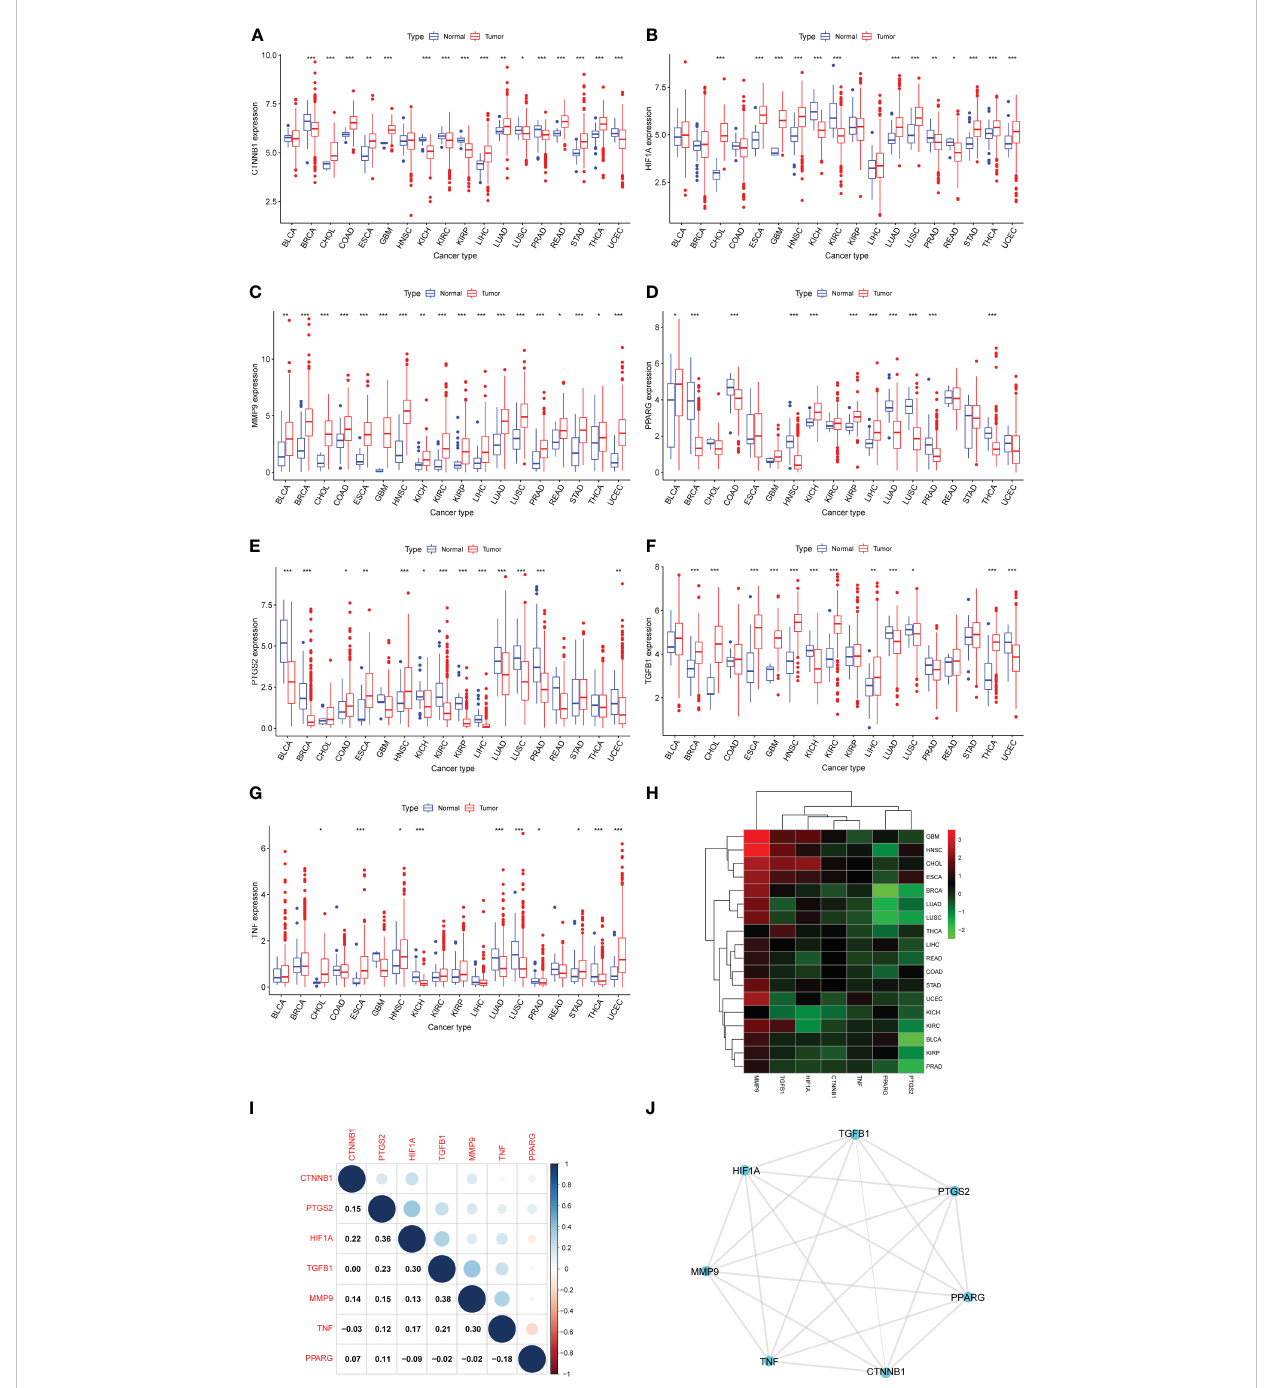
FIGURE 2 Differential expression analysis. (A – G) The box plots showing differential expression of the seven DCRGs in normal and tumor tissues ( ∗∗∗ P < 0:001; ∗∗ P < 0.01; ∗ P < 0.05). (H) The heatmap showing the transcriptional level of the seven DCRGs between normal and tumor tissues in various cancers. The gradient colors represent the log Fold Change (logFC) value. (I) The heatmap shows the pairwise correlation of the seven DCRGs. (J) The protein-protein interaction network of the seven